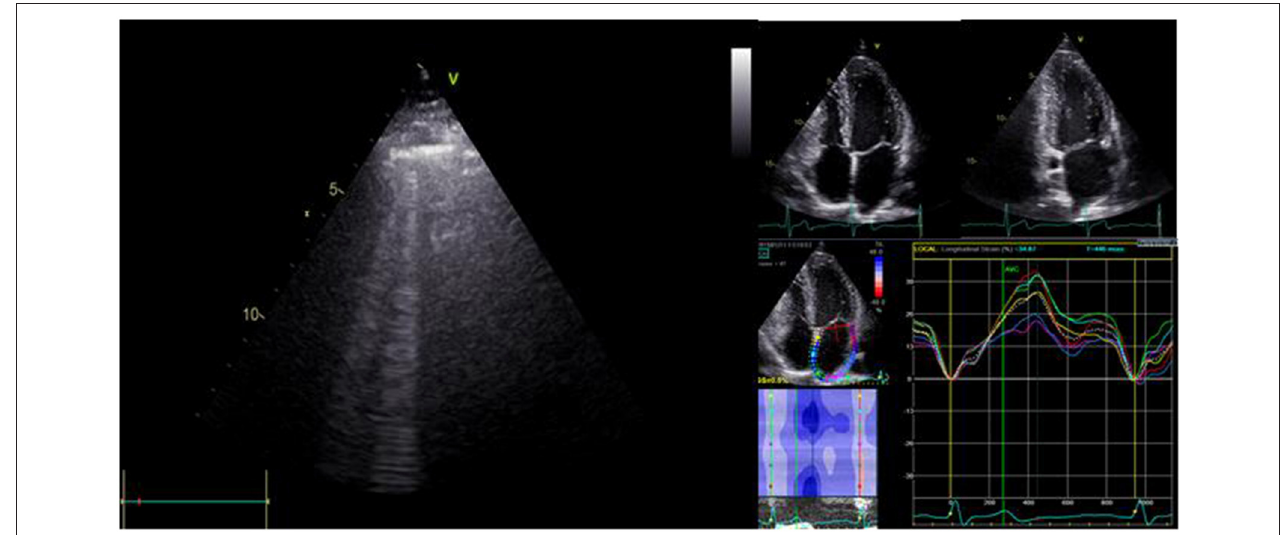
FIGURE 1 | Assessment of B-lines by lung ultrasound and determination of left atrial reservoir strain (LASr) in patients with HFpEF.